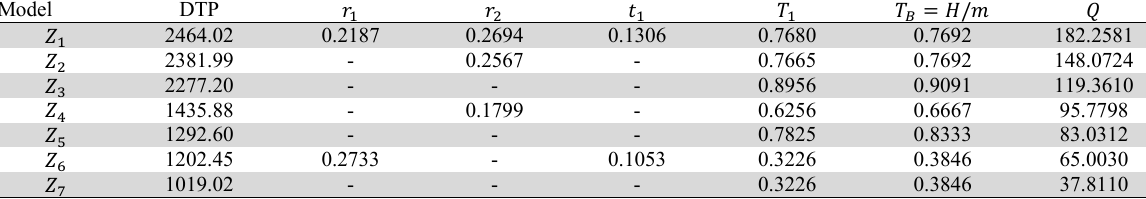
(Example 1). (cid:1872)(cid:1867) (cid:1852) (cid:2869) (cid:2875)